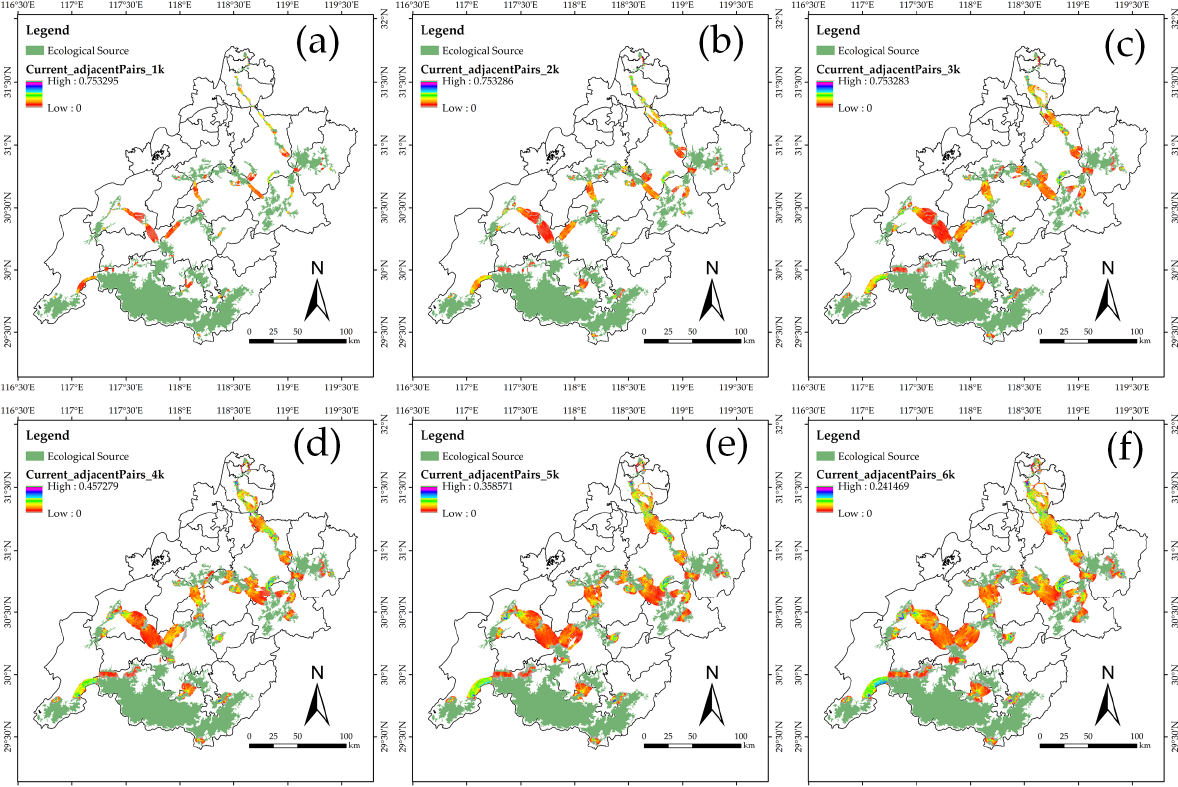
Figure A1. Ecological corridors in southern Anhui at different current thresholds (NOTE: Figure A1:( a )–( f ) represents the spatial distribution of corridors in the study area under different parameter (1000, 2000, 3000, 4000, 5000, 6000) settings).